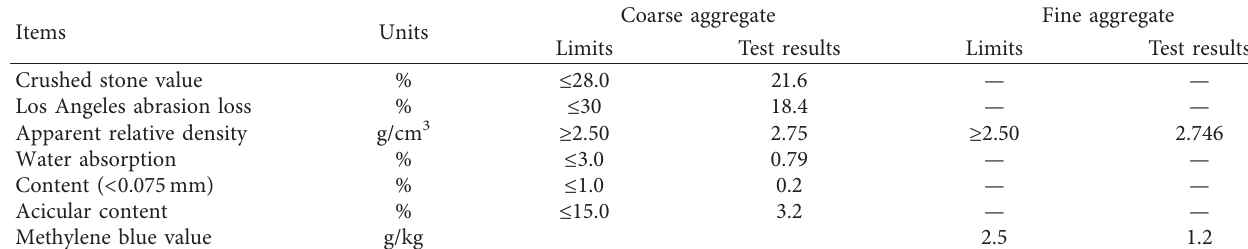
Table 4: Properties of aggregate.